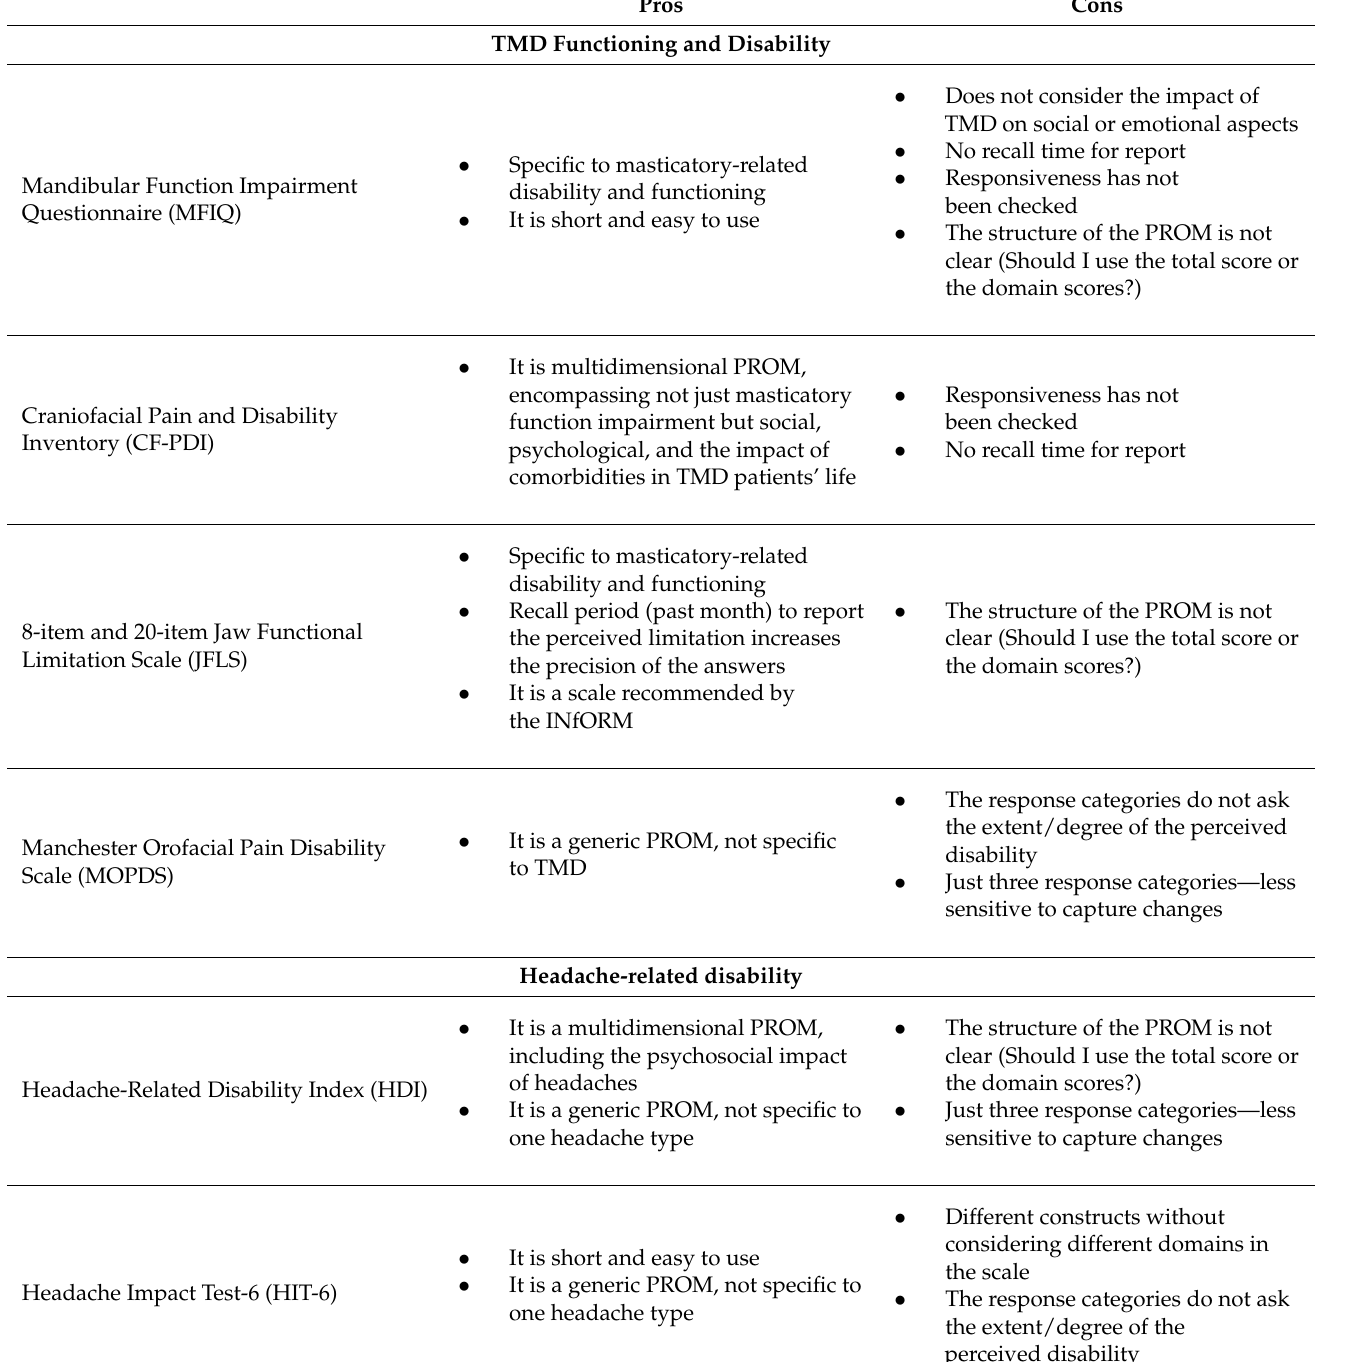
Table 12. Pros and cons of the patient-reported outcome measures included in the current review. Pros